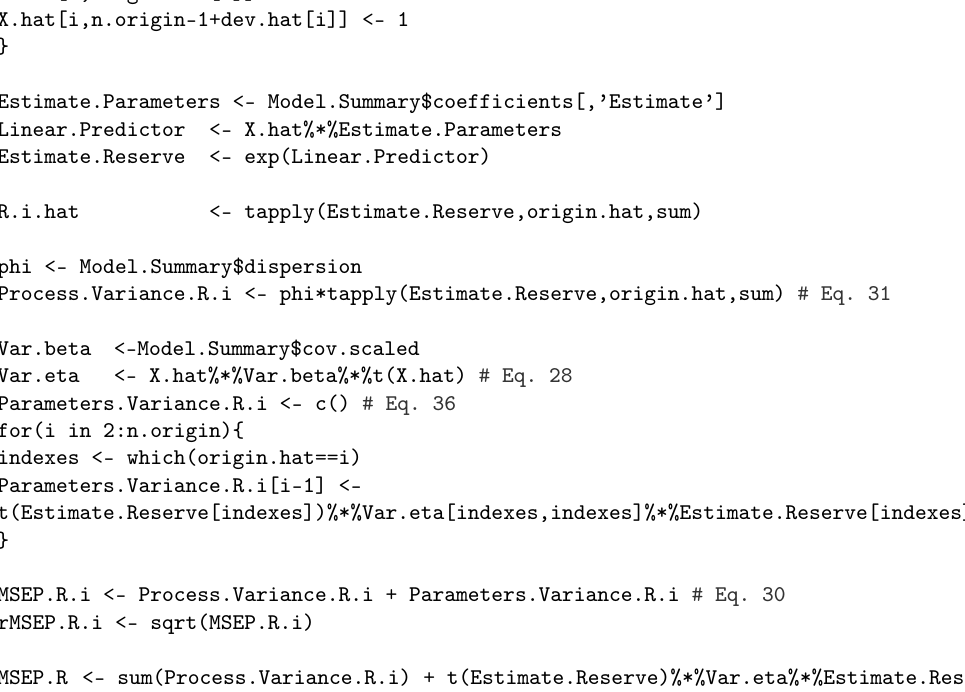
Table.4[,’R.BS’] Table.4[,’R.CT’] Table.4[,’delta.R’] <- Table.4[,’R.CT’]/Table.4[,’R.BS’]-1 Table.4[,’rMSEP.BS’] <- CDR.BS[,’IBNR.S.E’] Table.4[,’rMSEP.CT’] <- c(0,rMSEP.R.i,rMSEP.R) Table.4[,’delta.rMSEP’] <- Table.4[,’rMSEP.CT’]/Table.4[,’rMSEP.BS’]-1